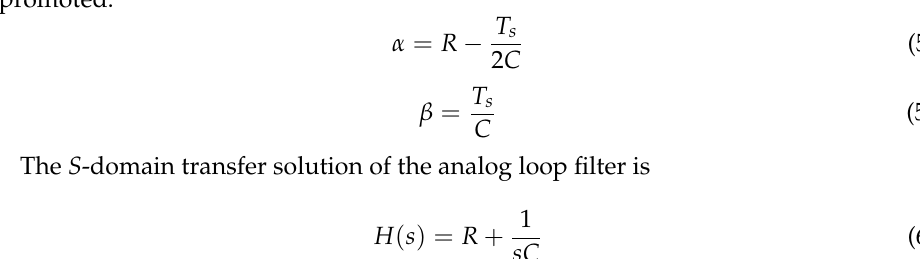
Figure 6. ( a ) Bilinear transformation of first-order digital loop filter for s-domain circuit and z-do- main circuit.; and ( b ) the proposed programmable divider structure.